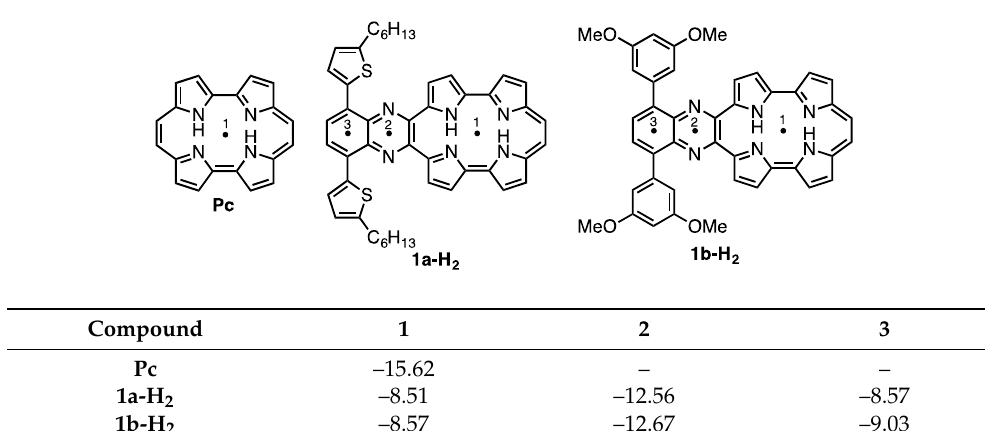
Figure 4. NICS(0) values of Pc , 1a-H 2 and 1b-H 2 .